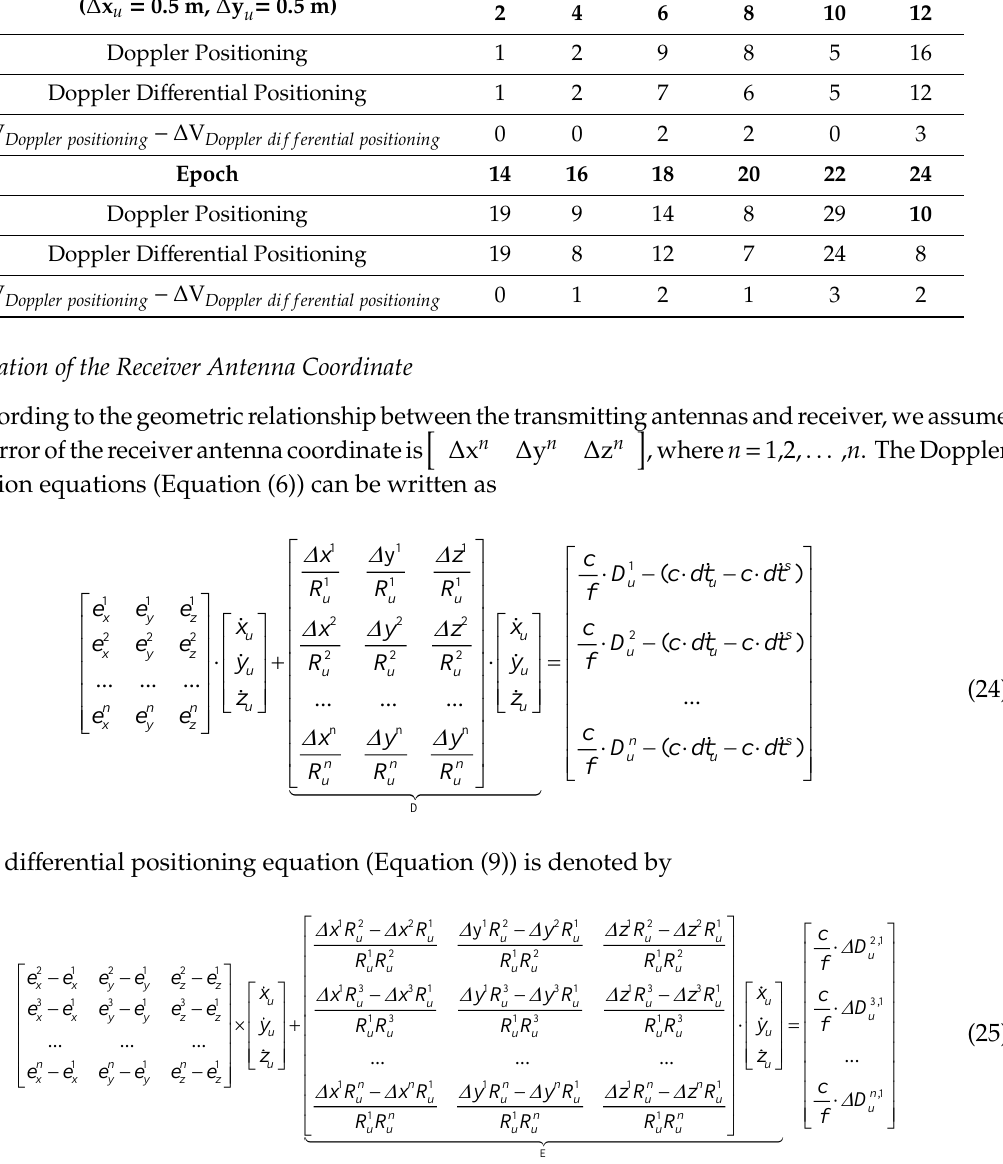
Table 6. Velocity measurement error caused by deviations of the receiver coordinates. Epoch = 0.5 ( ∆ x u = 0.5 m, ∆ y u